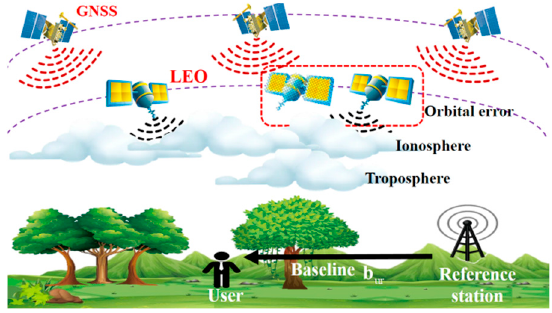
Figure 1. Application scenarios of D-LoeGNSS